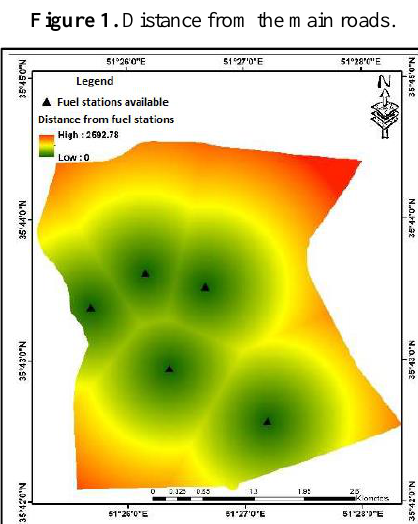
Figure 1. Distance from the main roads.